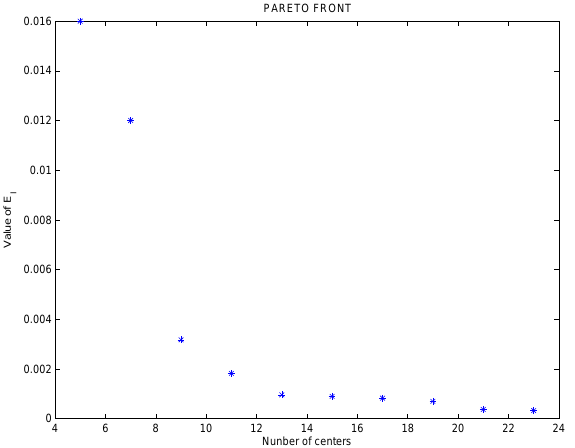
Figure 2. Pareto front of E L error vs. number of centers for f 1 ( x ) .